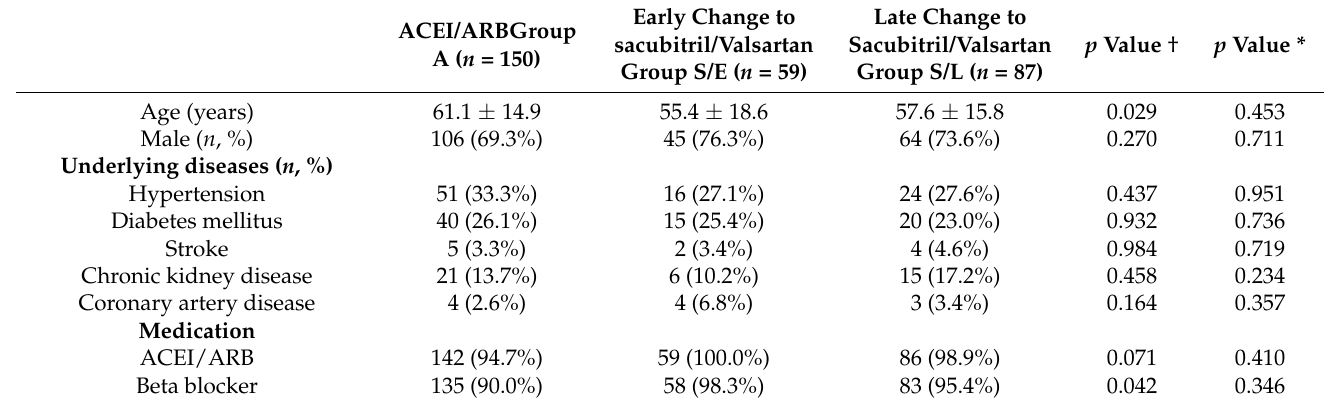
Table 1. Baseline characteristics according to the